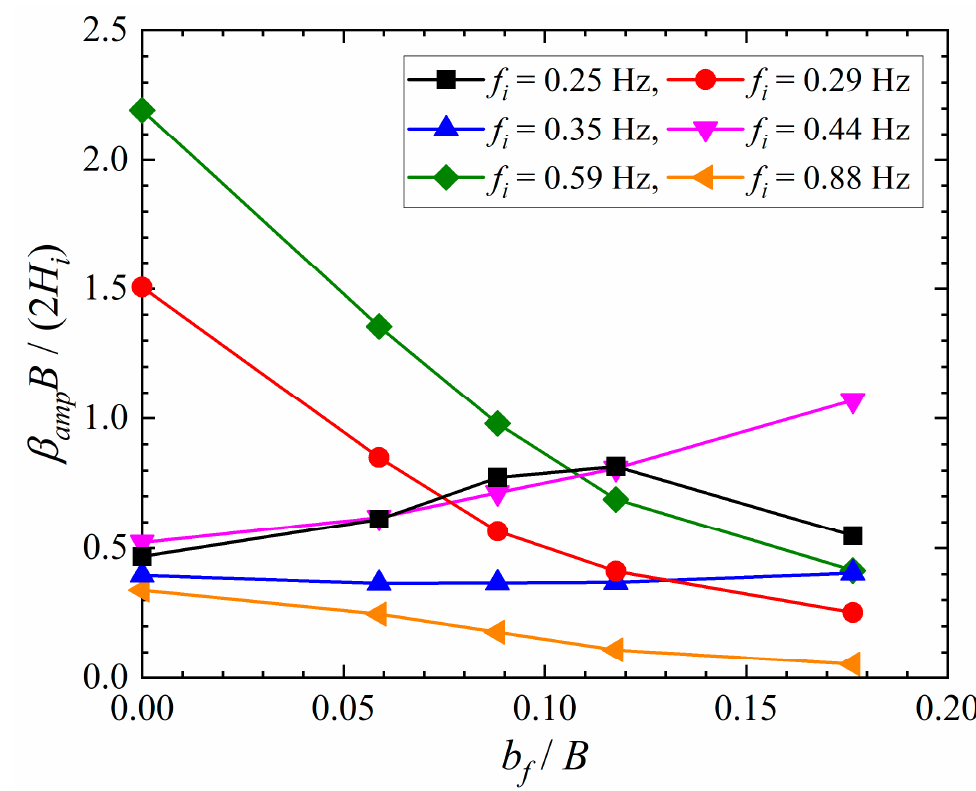
Figure 8. Relationship between β amp B /(2 H i ) and b f / B for the pitch motion.